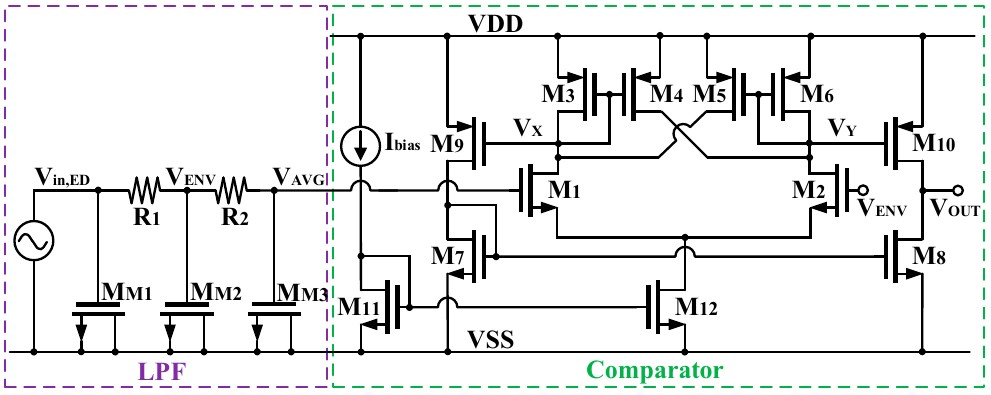
Figure 13. Schematic of proposed demodulator including low-pass filter and comparator.